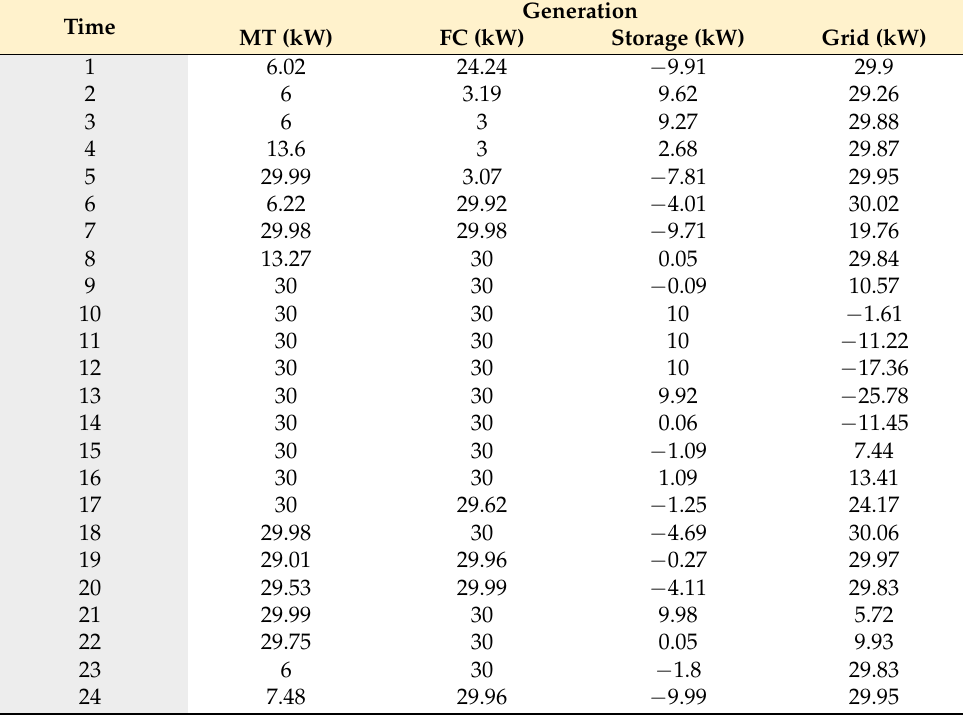
Table 17. Power distribution between generating resources to reduce costs without limitation of power exchange (total cost: $704.87).